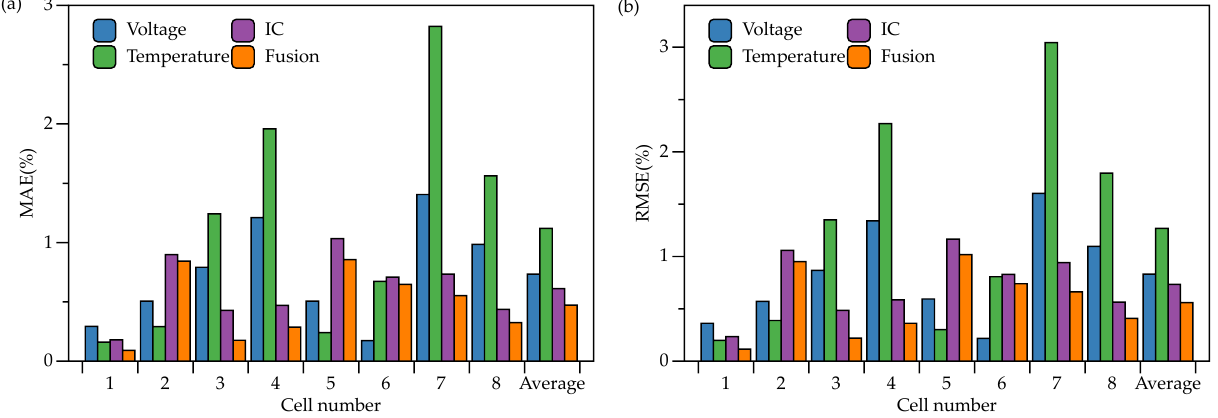
Figure 12. ( a ) MAE of different feature extraction strategies; ( b ) RMSE of different feature extraction strategies. Table 3. Summary of MAE and RMSE of different feature extraction strategies.